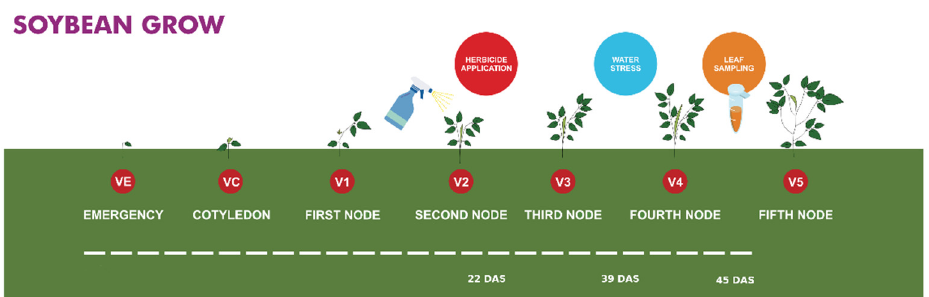
Figure 1. Schematic representation showing the timeline of soybean growth stages. Herbicide application, drought stress, and sample collection have been also included in color balloons indicating the time of the event within the soybean cultivation period.